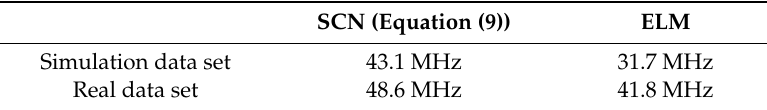
Table 7. Actual clock frequency of FPGA-based prediction